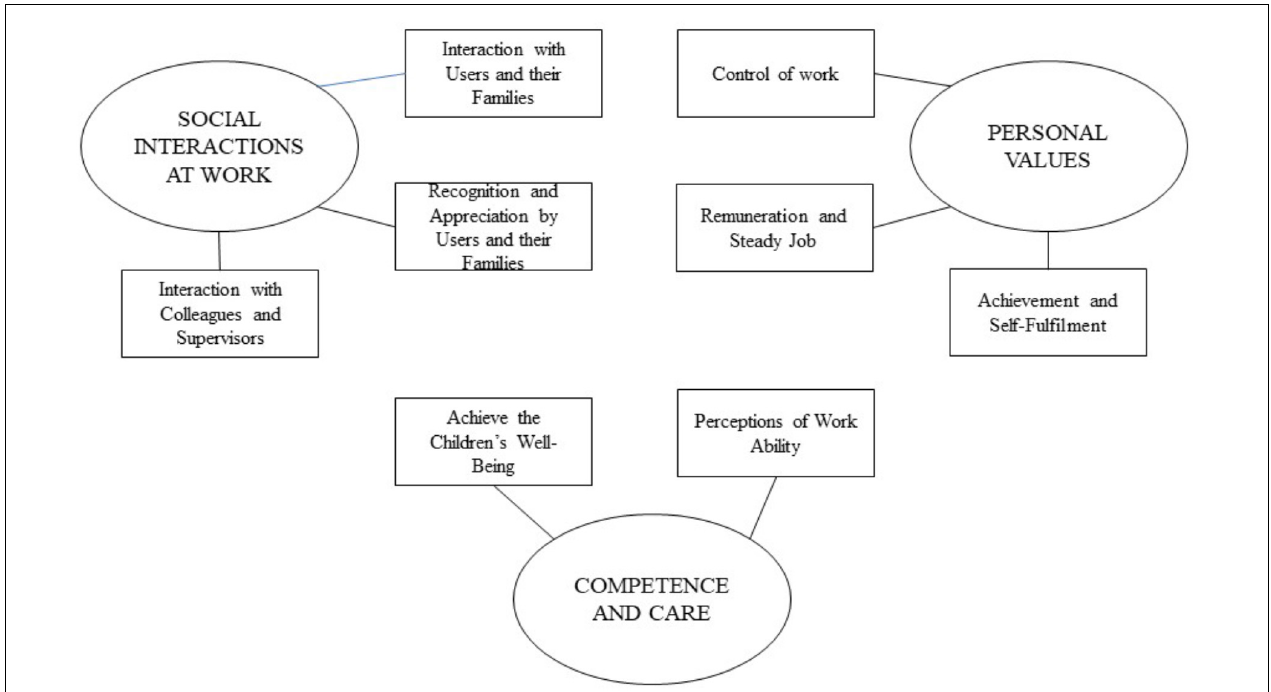
FIGURE 1 | Sources of job